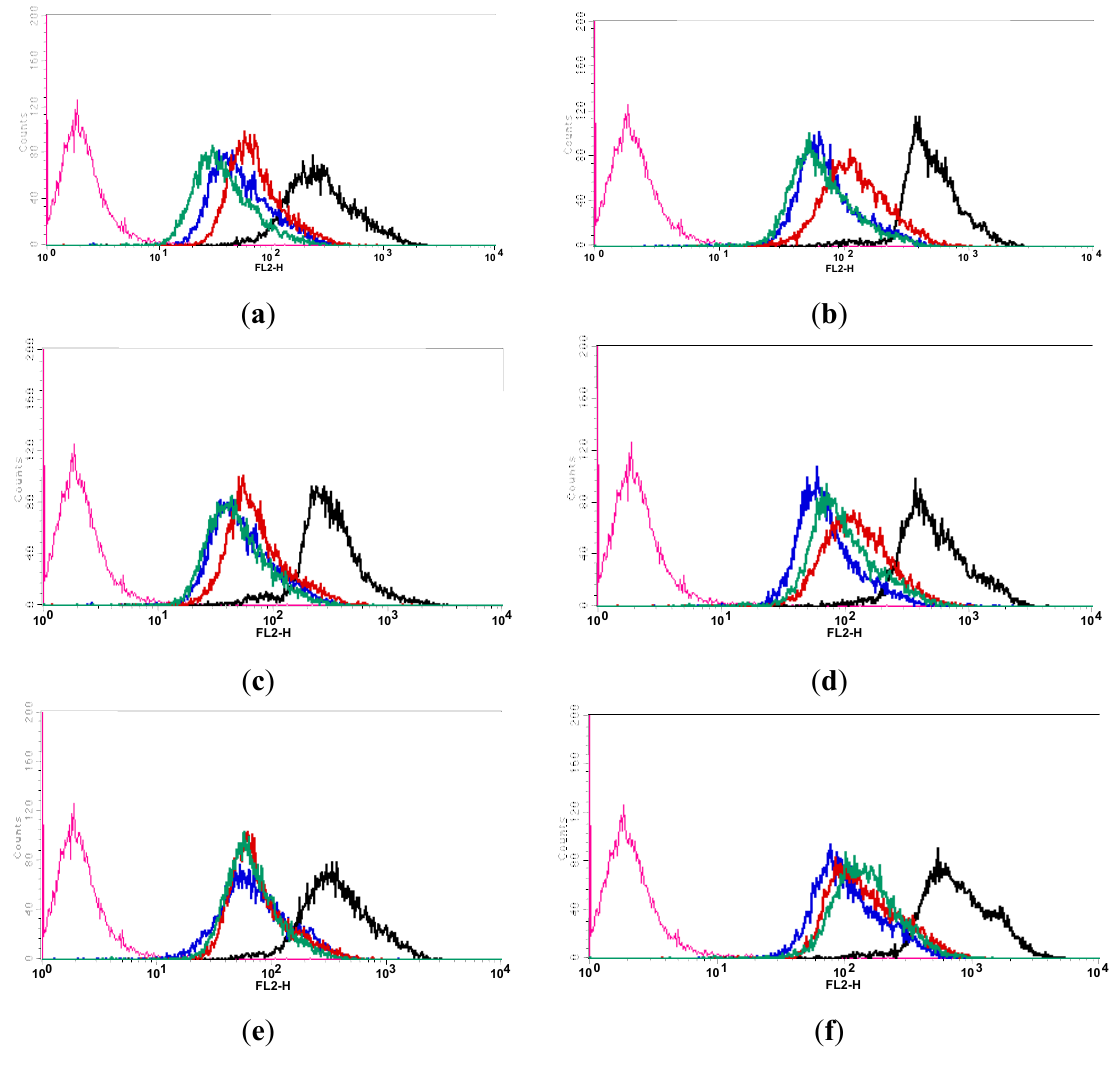
Figure 5. Flow cytometry histogram profile of MCF-7 cells that were incubated with free DOX, DOX-4SPCL-PEG-Folic micelle (DMC F) and DOX-4SPCL-PEG micelle (DMC 100 for 3, 8 and 24 h with DOX concentration of 5 µg/mL ( a , c , e ) and 10 µg/mL ( b , d , f ). (Pink: control, Blue line: DMC , Red: DMC F, Black: free DOX, Green: free folic 100 100 acid + DMC F). The y -axis indicates the counts of the fluorescence 100